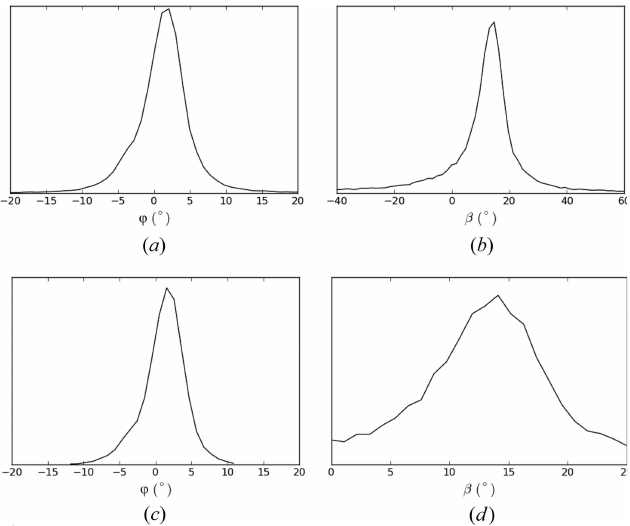
Figure 7 Distributions of ’ and (cid:2) , ( a ) and ( b ) for all accepted patterns, and ( c ) and ( d ) after removing patterns with the estimated (cid:2) outside the range 0–25 (cid:3)